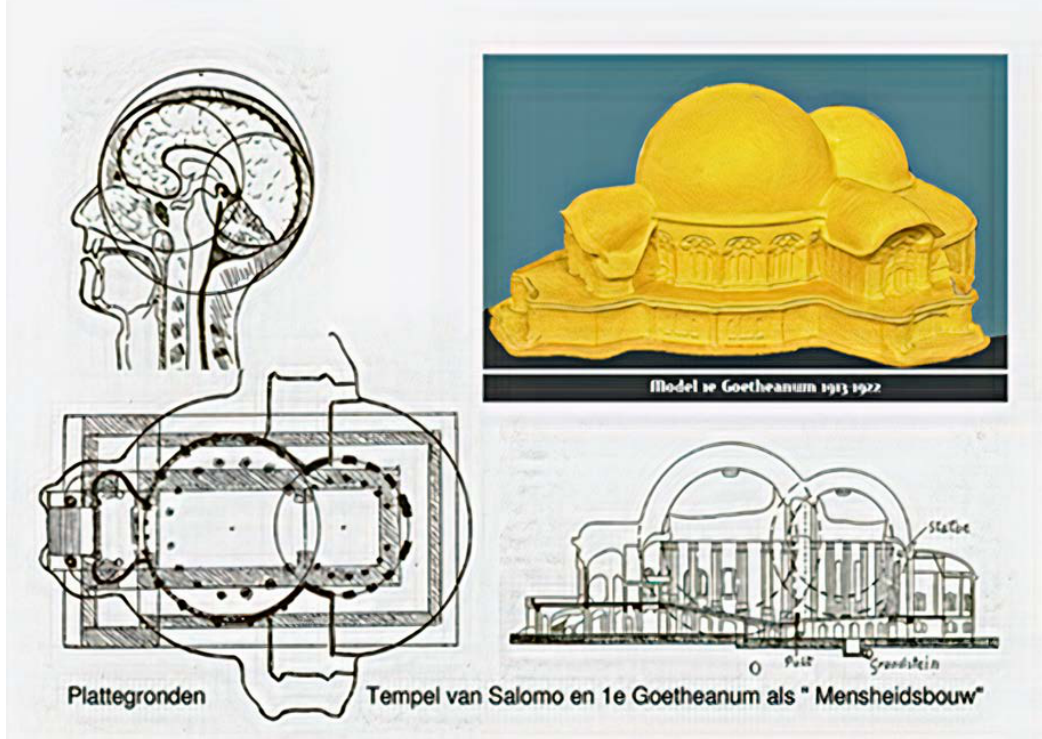
Figure 2. The philosophical structure of the first Goetheanum according to Perotti L. [16].